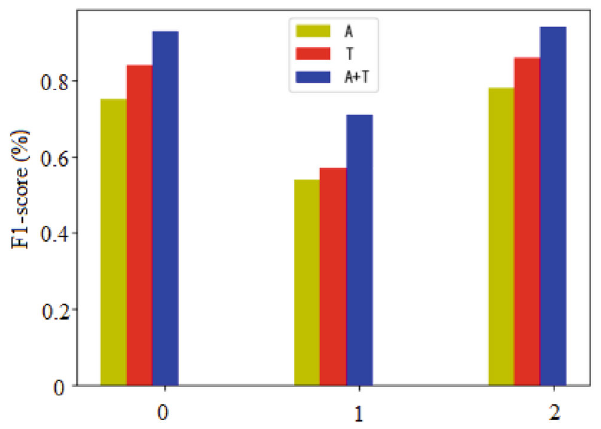
Fig. 8 Classification accuracy comparison between the fusion model and single model